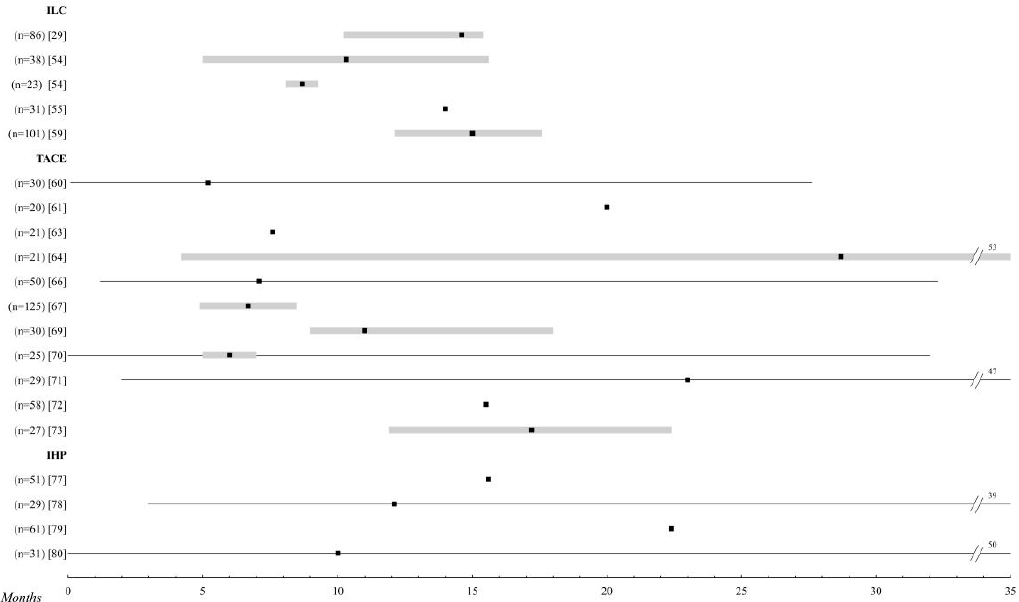
Figure 2. Locoregional chemotherapy. Comparison of the overall survival of the different treatments for metastatic UM. Those studies with n > 20 patients were selected. The black square indicates the median, and the 95% confidence intervals are represented in a grey bar. The range is established by the black lines. The overall survival is shown up to 35 months; when it is extended, the maximum time data (in months) is added. Abbreviations: ILC, intra-arterial liver chemotherapy; TACE, transarterial liver chemoembolization; IHP, isolated liver perfusion .